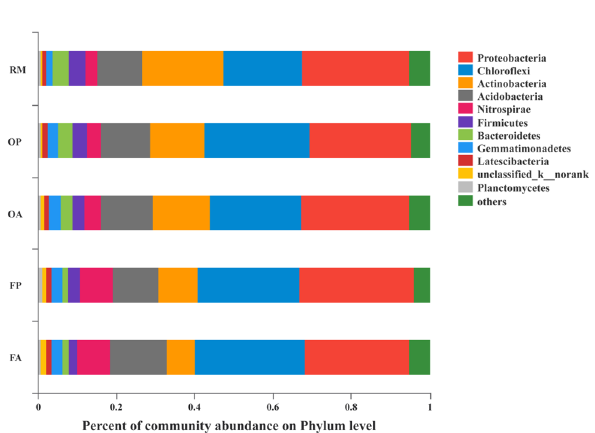
Figure 1. The average relative abundances on phylum level of soil bacterial communities in different rice systems and